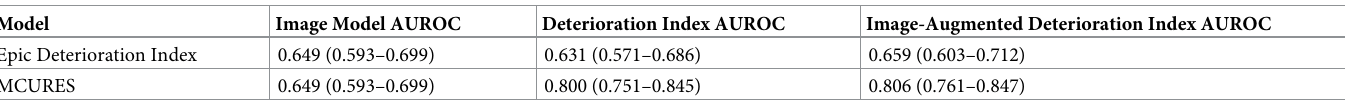
Table 2. Reported area under the receiver operating characteristic (AUROC) and 95% CIs for each deterioration index for identifying high-risk patients within the first five days of admission.